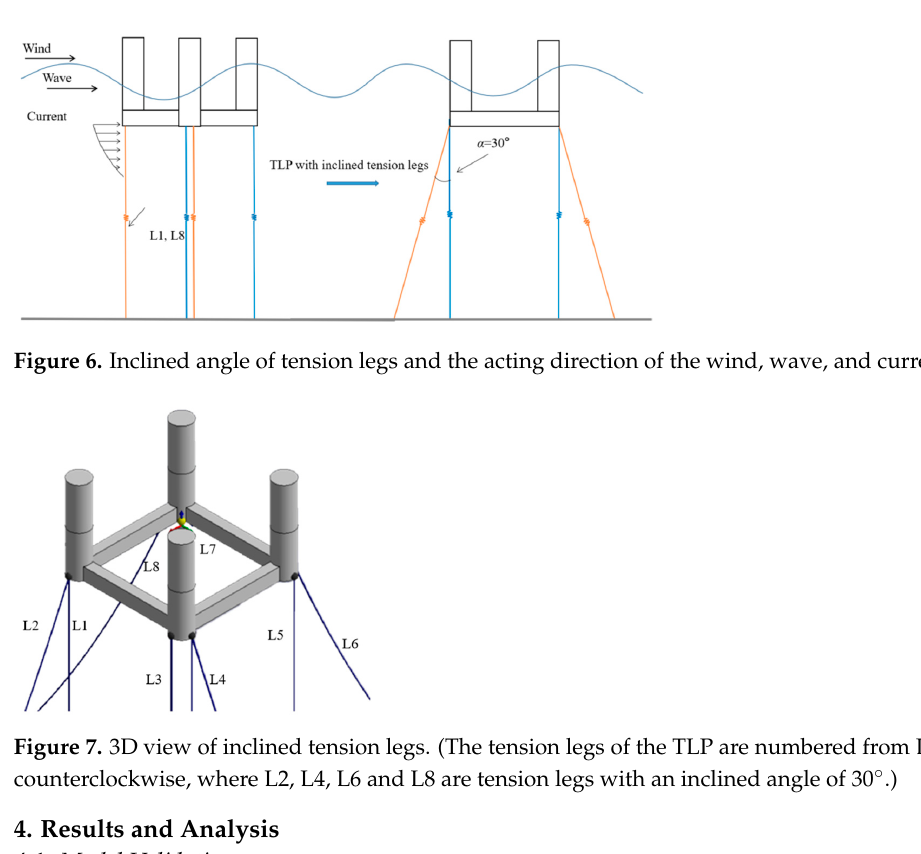
Figure 9. Pitch motion of TLP under different wave heights. . Figure 10. Surge response spectrum.